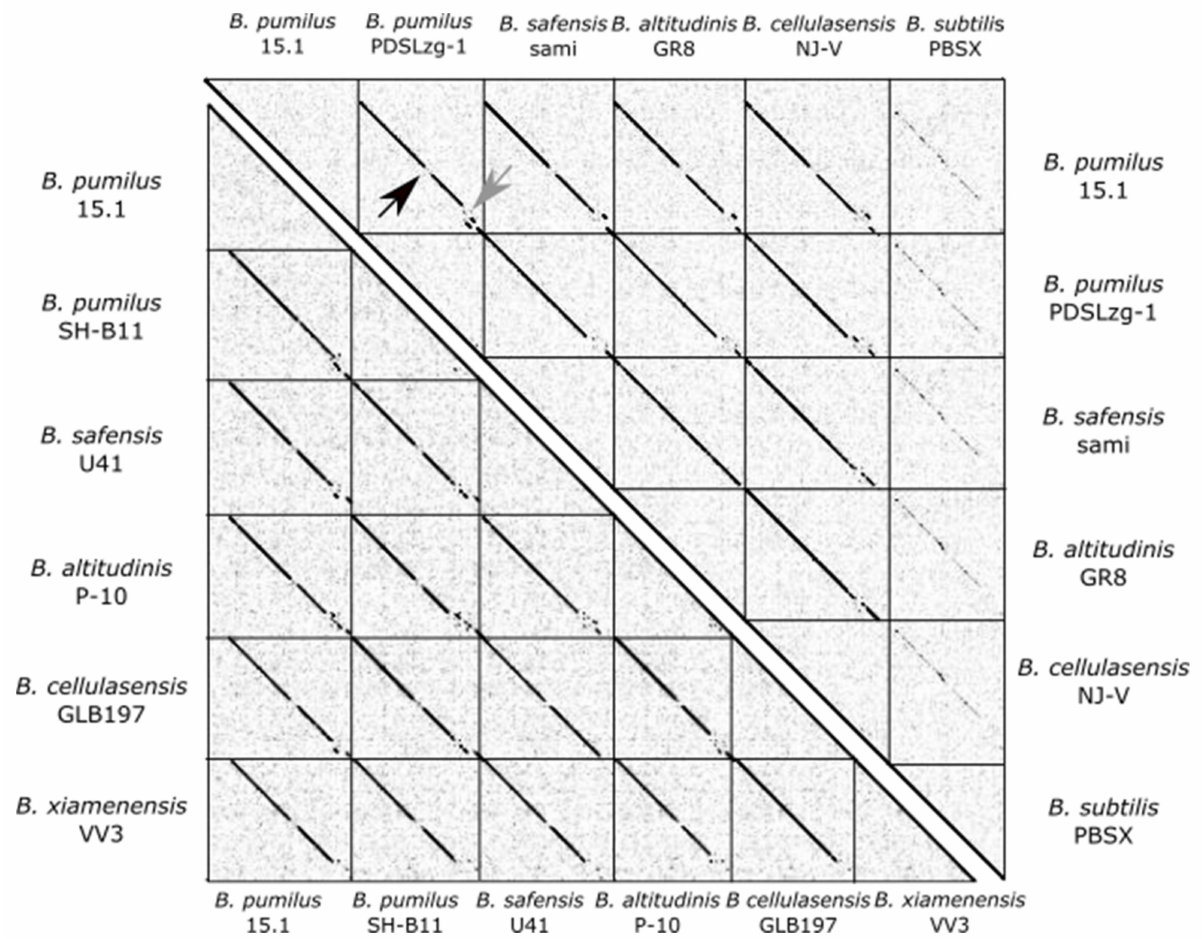
Figure 2. Whole-genome dot-plot comparison of some PBSX-like particles sequences from bacteria belonging to the B. pumilus group (shown in bold in Table 2). A comparison was made with Gepard 1.40 [43] with a word length of 10